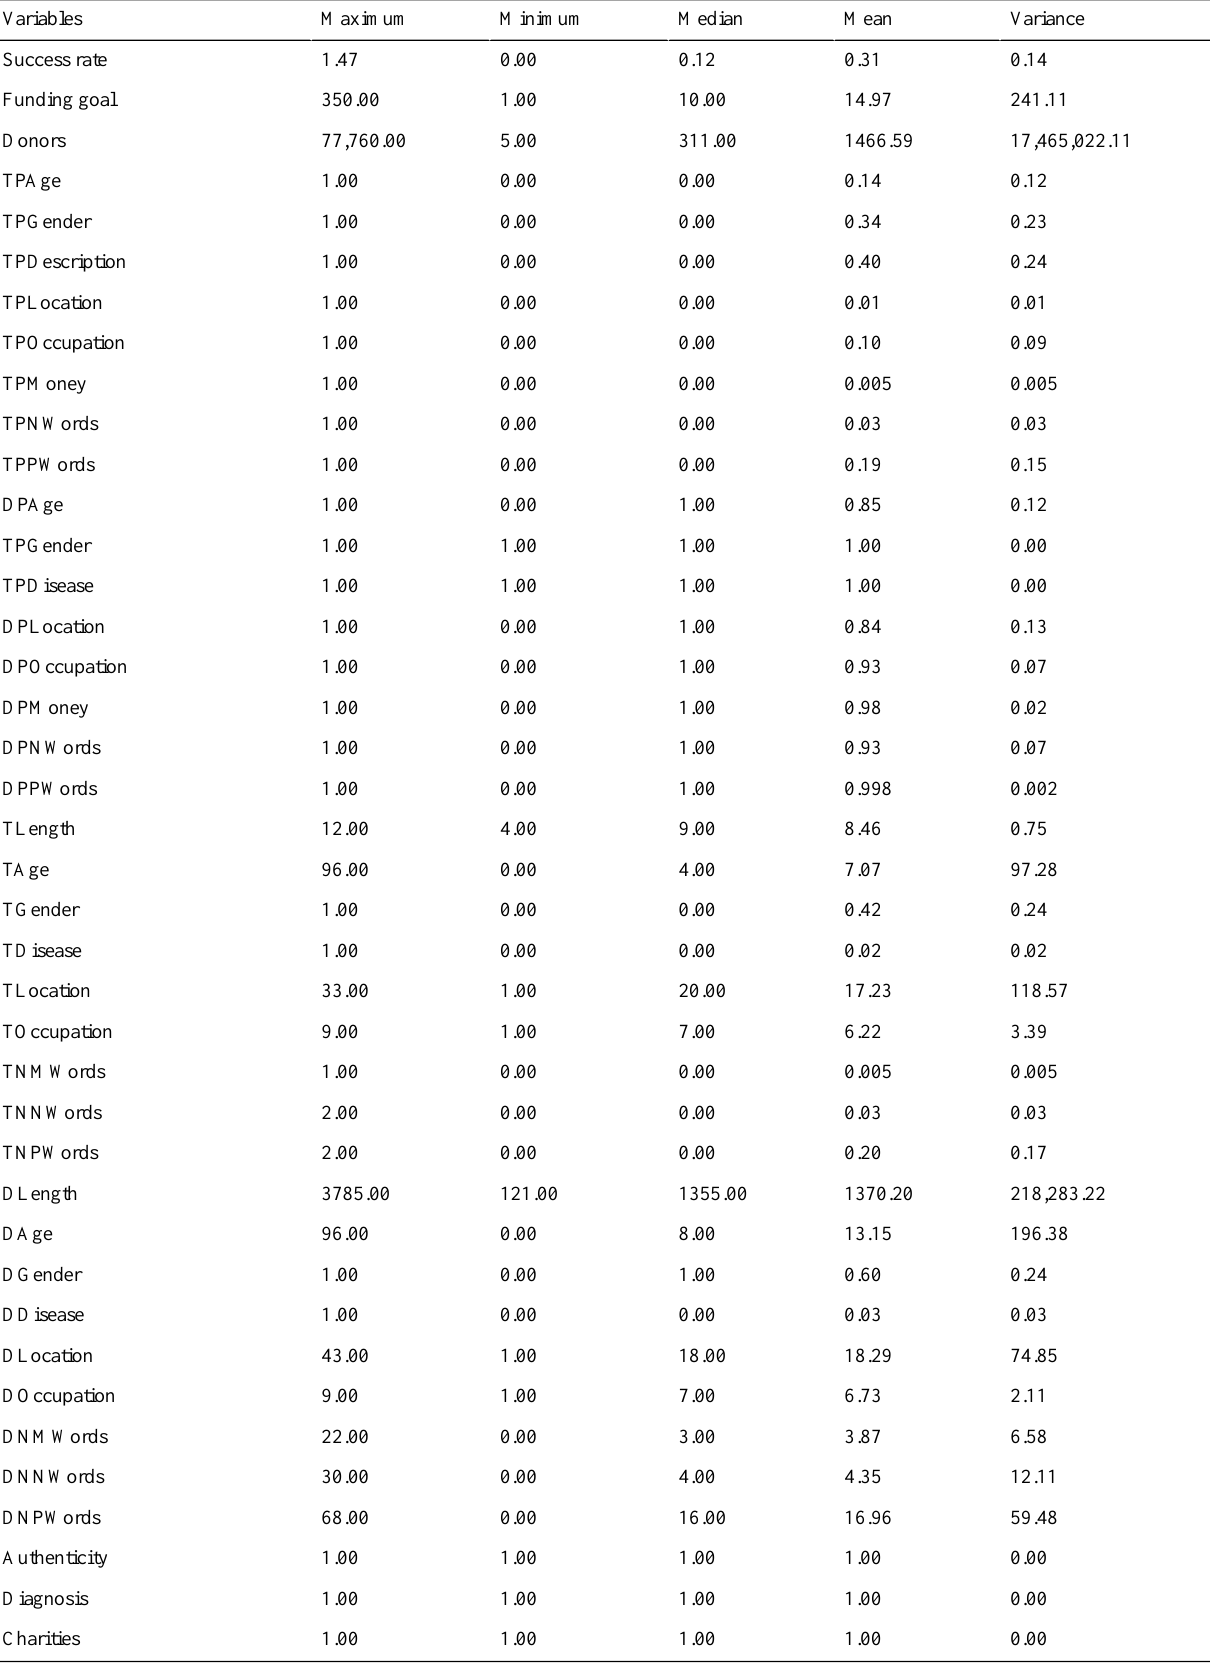
Table 3. Descriptive statistics of